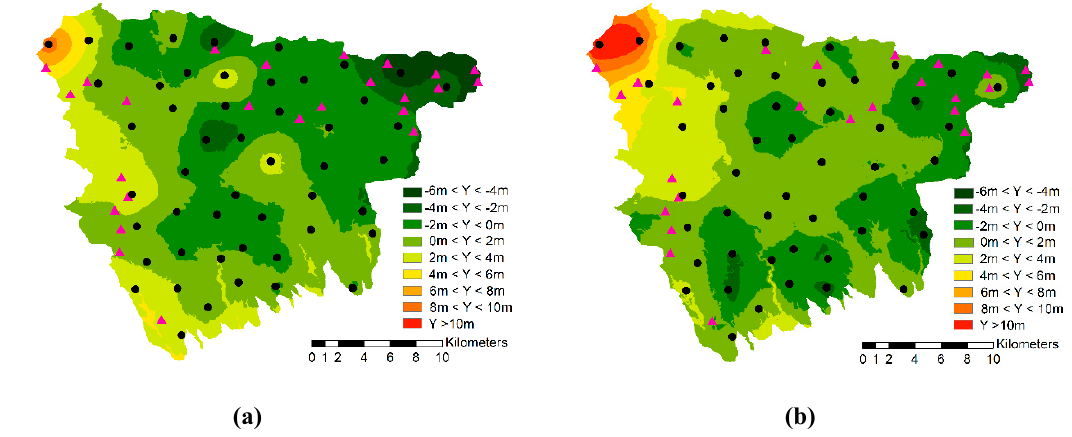
Figure 10. Error maps along the two axes. ( a ) Error X; ( b ) error Y. The black points indicate the 50 GCP dataset, whereas the red triangular points represent the newly introduced GCPs.